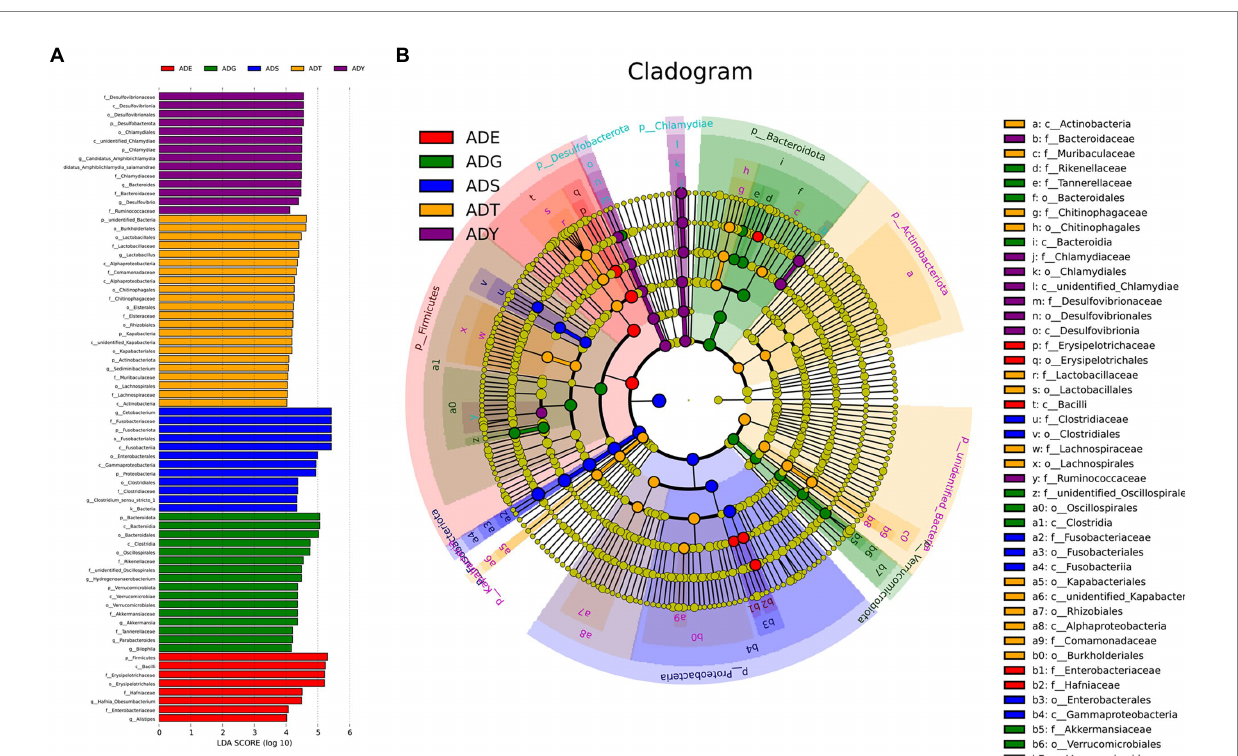
FIGURE 7 Beta diversity of microbial communities in guts of A. davidianus at different growth stages. (A) Histogram of linear discriminatory analyses (LDA) score distribution. (B) Cladogram of LDA effect size (LEfSe) of microbial taxa (LDA > 4).